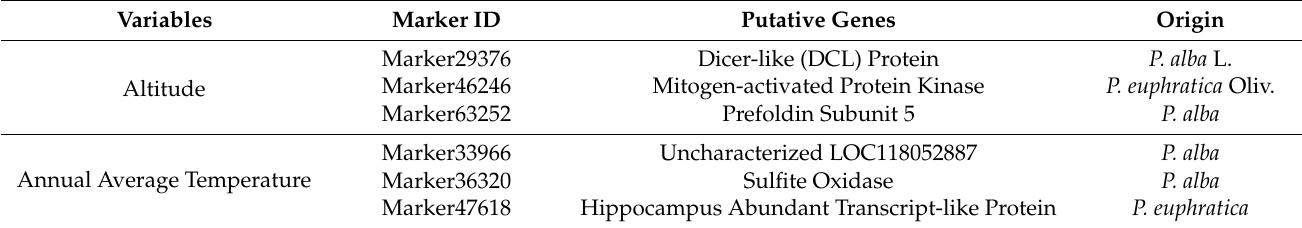
Table 7. Sequence alignment of the candidate SNP markers for functional